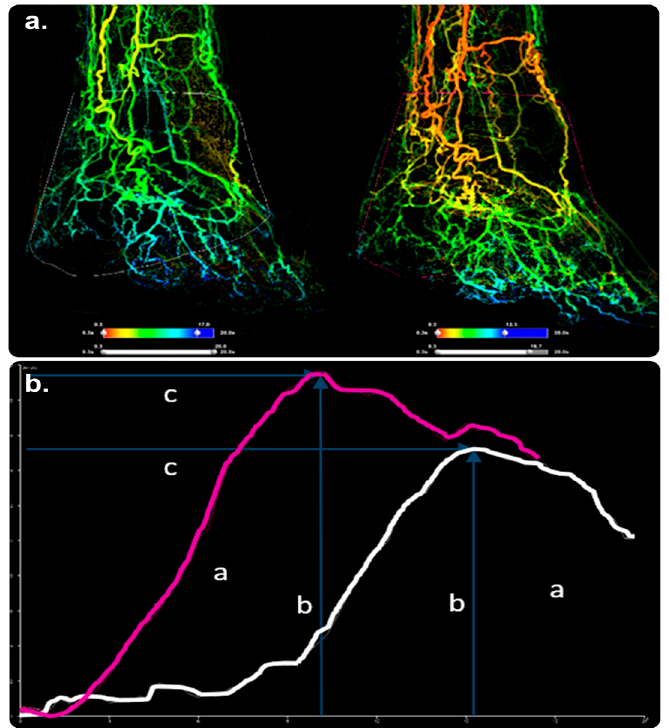
Figure 14. SmartPerfusion software and its role in postprocedural checking. ( a ) 2D reconstituted perfusion images of the foot in anterior–posterior views before and after PTA of the tibioperoneal trunk. (a, right image) shows higher blood supply in the foot after treatment. ( b ) A significant increase in contrast passage, as demonstrated by a larger AuC (a), higher peak density (b), and shorter time to peak (c). SmartPerfusion demonstrated a significant improvement in foot perfusion, unlike DSA, which failed to show a convincing treatment impact. Abbreviations: AuC, area under the curve; DSA, digital subtraction angiography; PTA, percutaneous transluminal angioplasty. (Original copyrights).